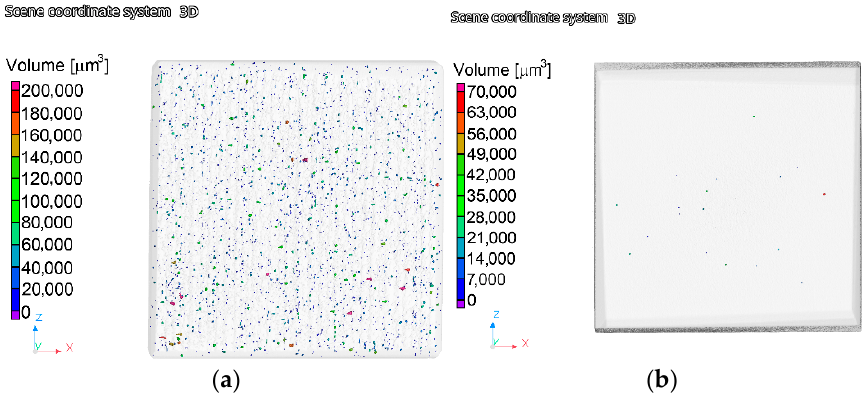
Figure 5. Results of the analyses of the porosity: SLM sample ( a ); 4 sample ( b ).